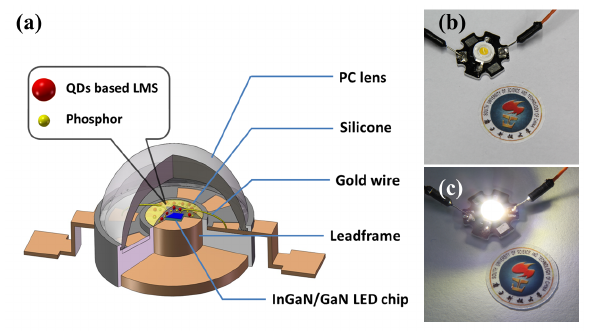
Figure 5: (a) Schematic of LMS-optimized WLED. (b) As-fabricated WLED based on LMS and YAG:Ce phosphors. (c) LMS–WLED oper- ating at 20 mA. LMS: luminescent microspheres; WLED: white light emitting diode.